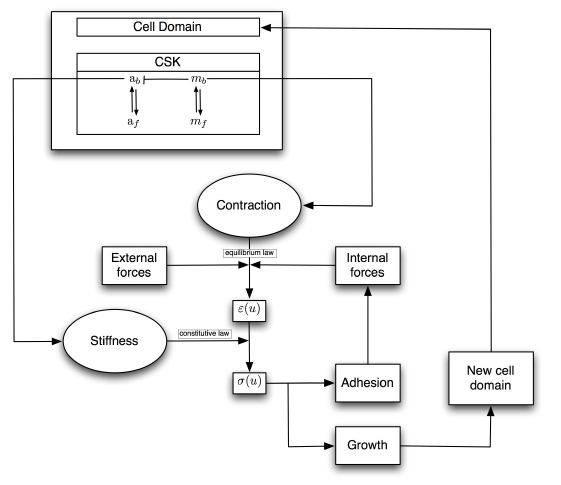
Figure 1. Scheme of the mathematical model considering the actin and myosin concentrations, the cellular deformations and stresses, the force contraction generated by the cell and the cell growth during the process. For cytoskeleton (CSK) dynamics, free actin a f is considered an activator of bound actin a b , bound myosin m b an inhibitor of bound actin a b and free myosin m f an activator of bound myosin m b